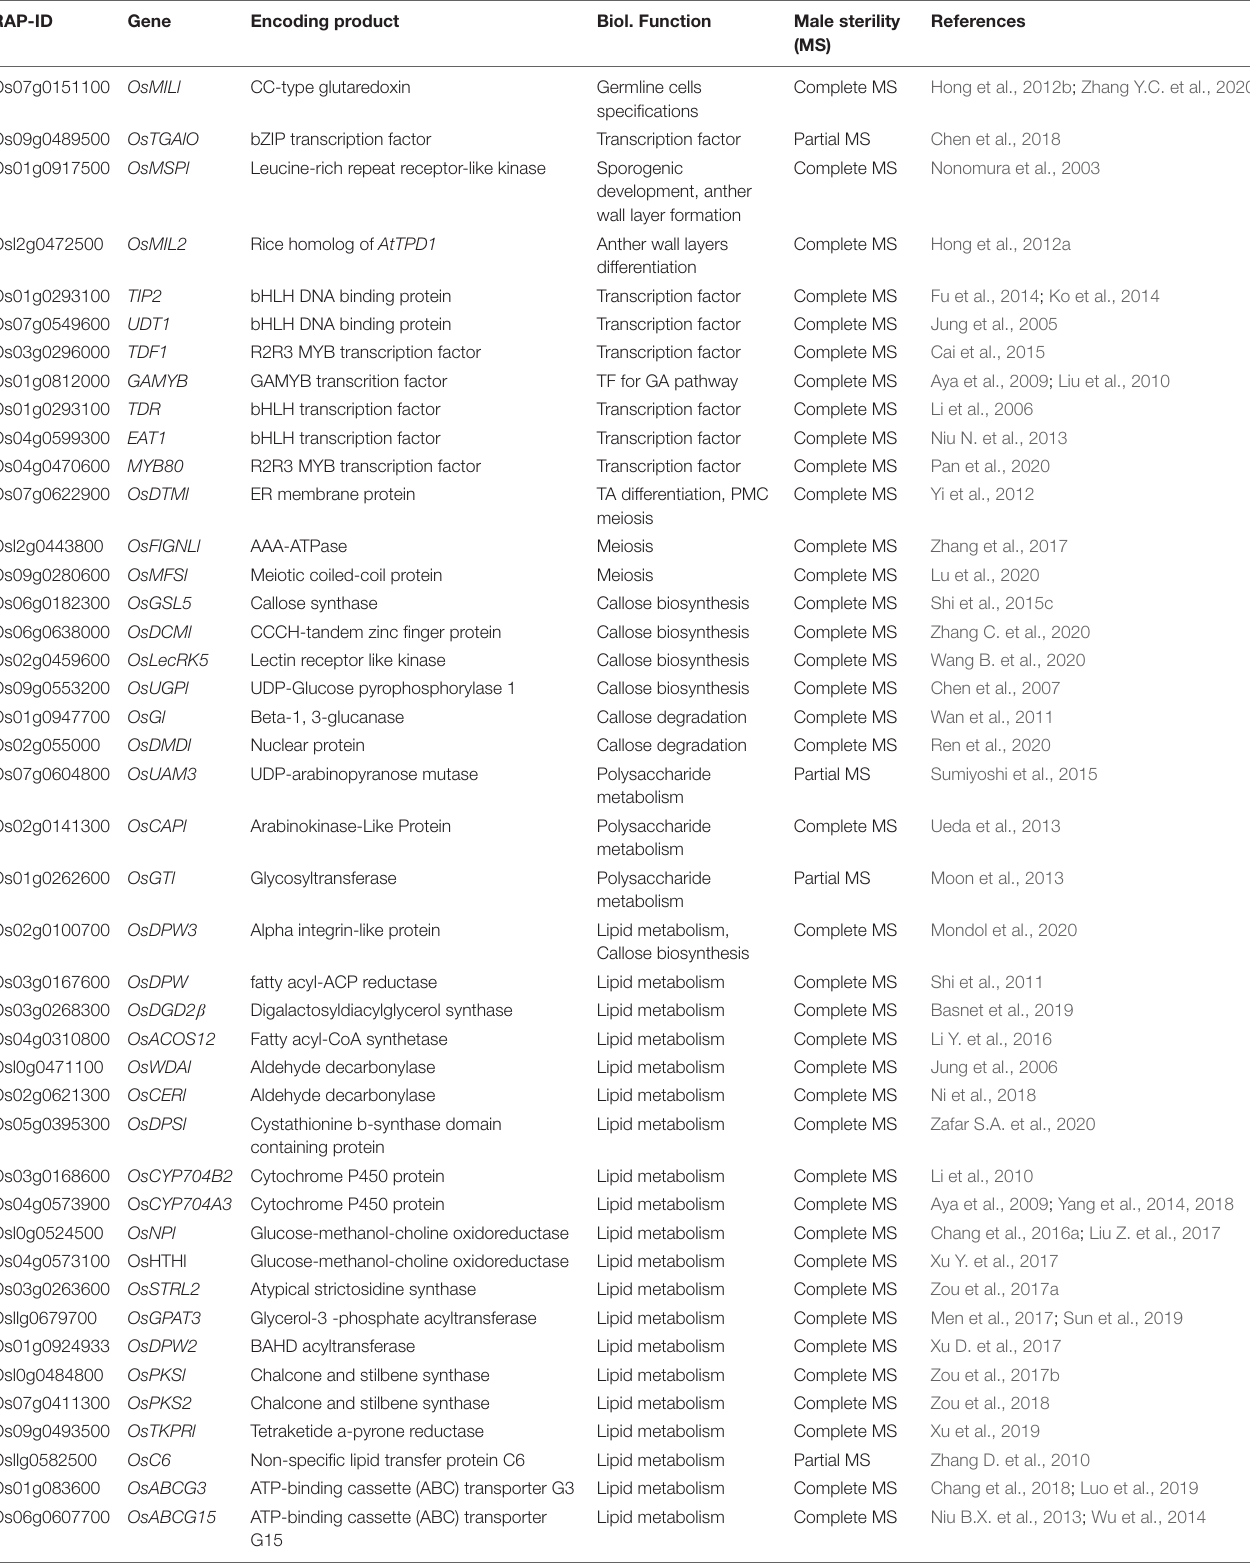
TABLE 1 | List of the characterized genes for genetic and biochemical regulation of anther and pollen development in rice. RAP-ID Gene Encoding product Biol.